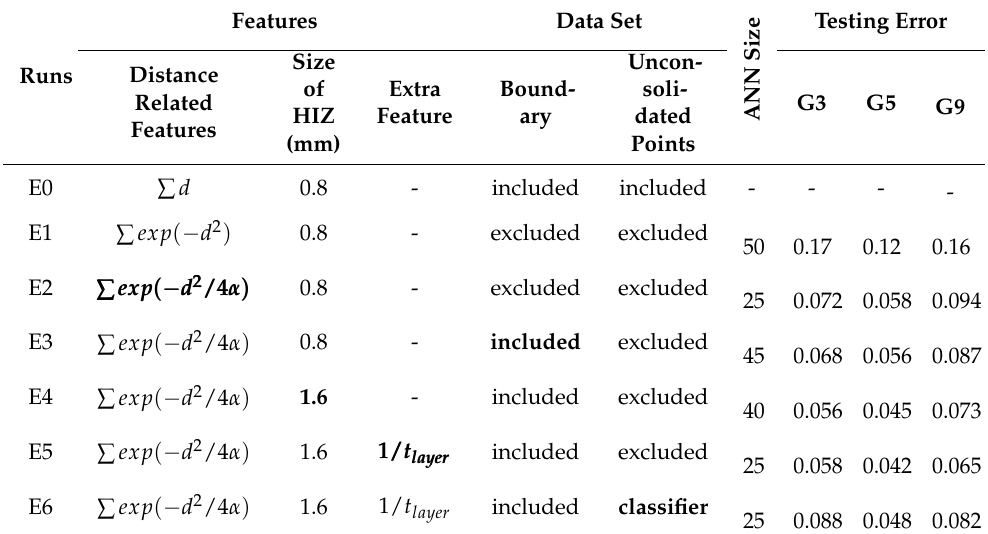
Table 4. Engineering the